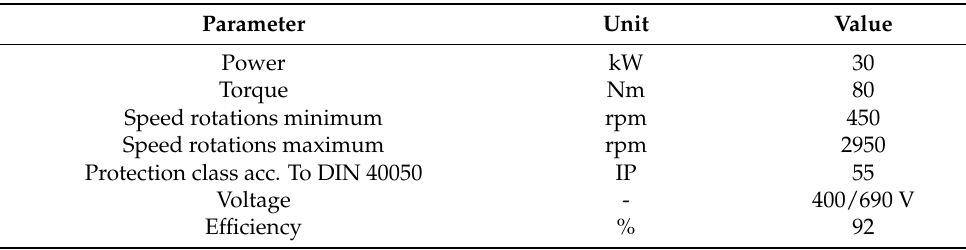
Table 7. Design of electric motor